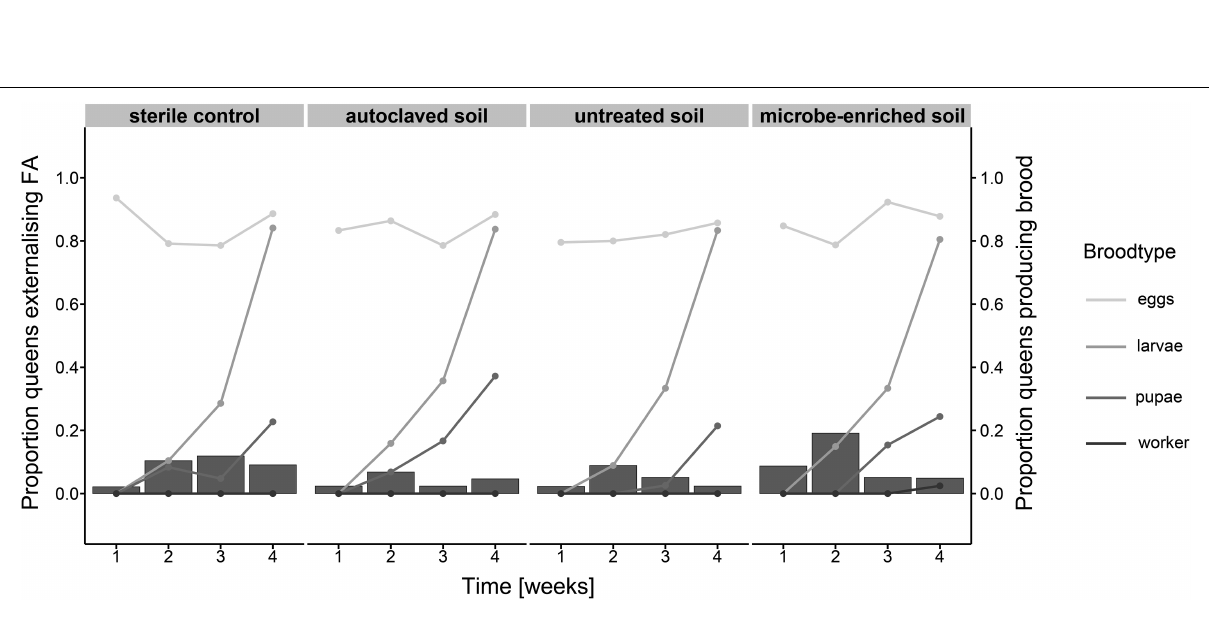
FIGURE 4 | The proportion of queens externalizing formic acid (FA) in their environment (bars) and producing brood (points with connecting lines with gray shades from light gray to black for eggs, larvae, pupae, and workers respectively) over the course of 4 weeks under different environmental conditions (sterile control, autoclaved soil, untreated soil, and microbe-enriched